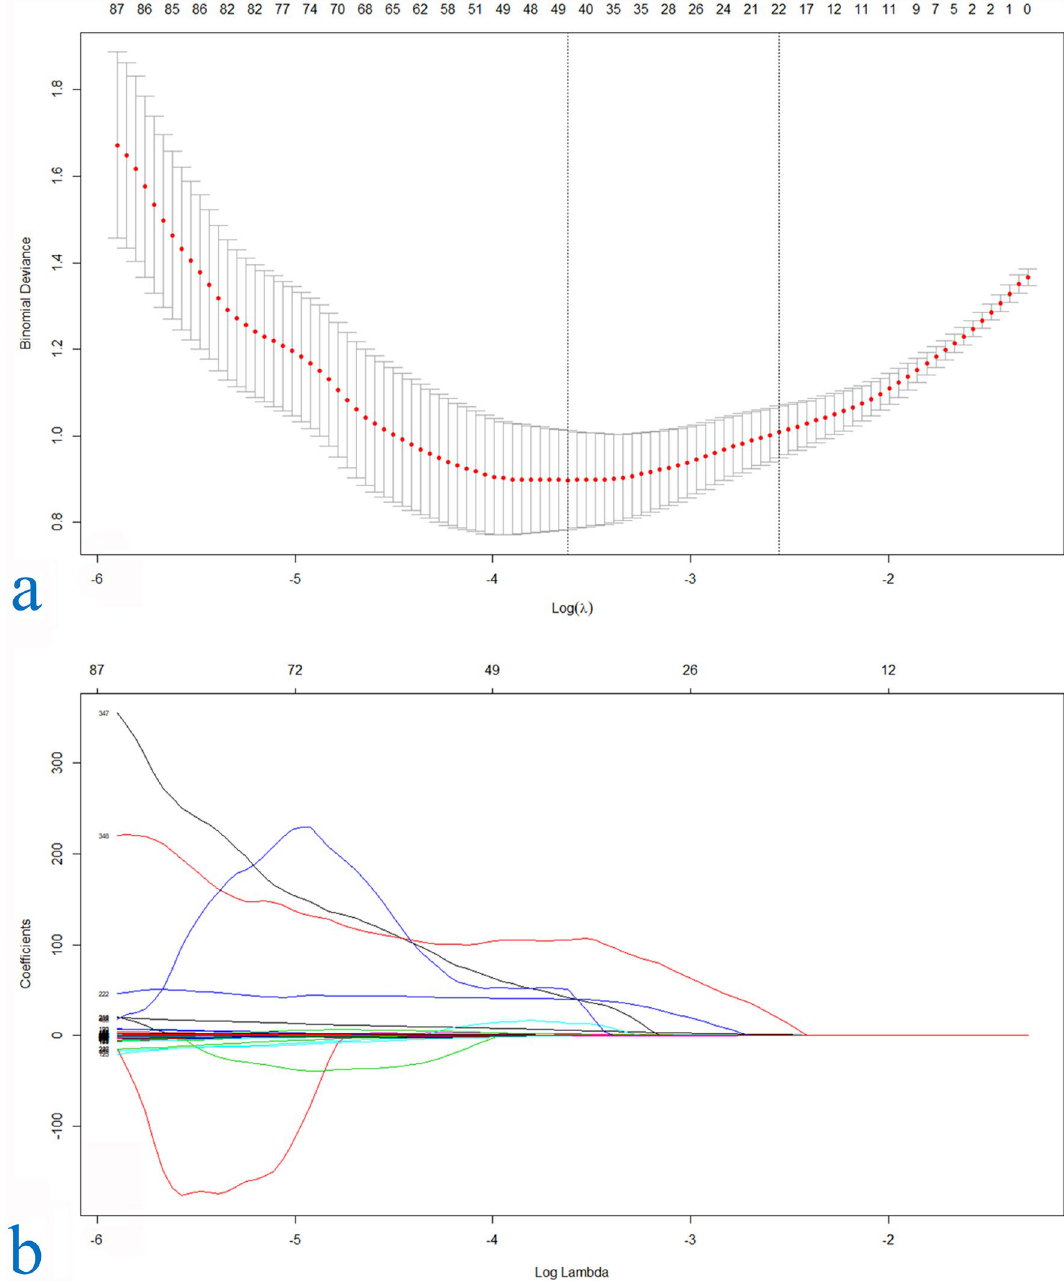
Figure 6. LASSO regression dimensionality reduction. Texture feature selection using the least absolute shrinkage and selection operator (LASSO) binary logistic regression model. ( a ) Tuning parameter (l) selection in the LASSO model used ten-fold cross-validation via minimum criteria. The area under the receiver operating characteristic (AUC) curve was plotted versus log(l). Dotted vertical lines were drawn at the optimal values by using the minimum criteria and the 1 standard error of the minimum criteria (the 1-SE criteria). An l value of 0.009, with log (l), 24.709 was chosen (1-SE criteria) according to ten-fold cross-validation. ( b ) LASSO coefficient profiles of the 490 texture features. A coefficient profile plot was produced against the log (l) sequence. A vertical line was drawn at the value selected using ten-fold cross-validation, where optimal l resulted in 23 nonzero